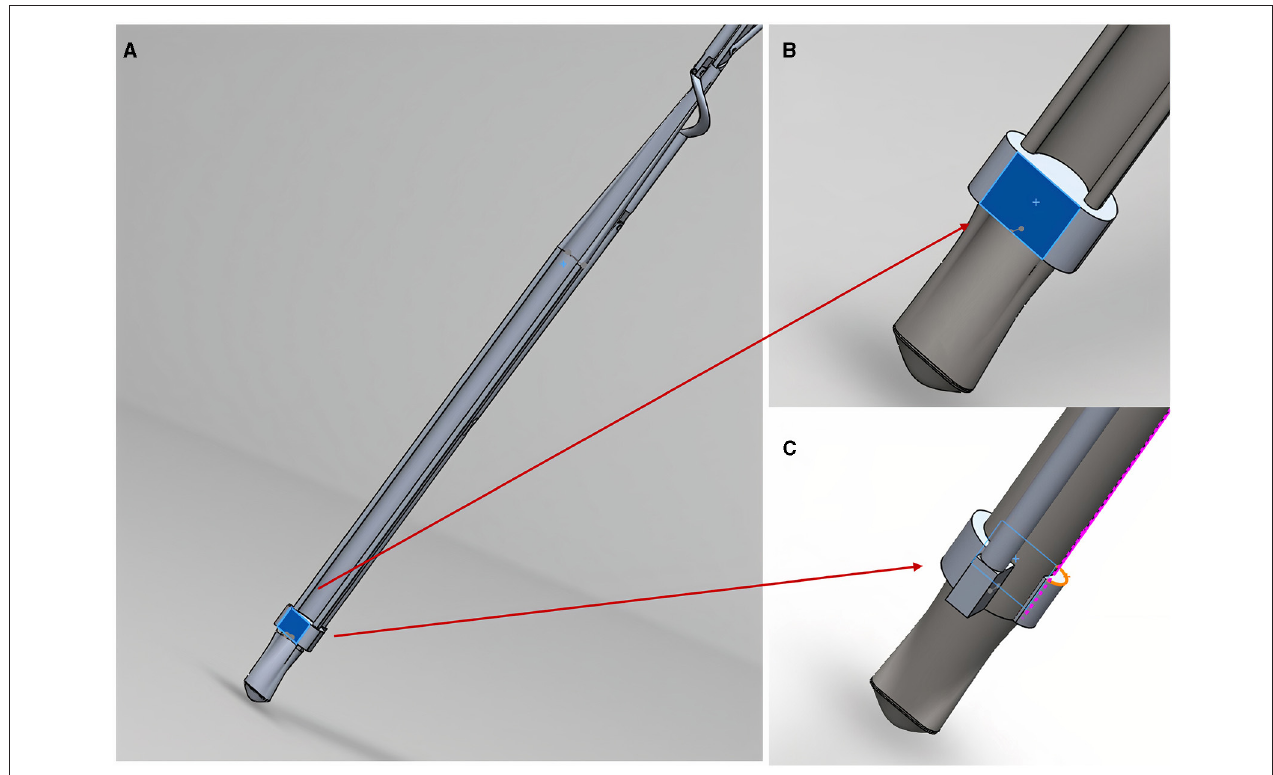
FIGURE 3 | The patch releasing mechanism in close-up. (A) Shows an arm patch attachment point/platform (highlighted in blue); (B) shows anterior view close-up of the platform where a hook/nodule (not shown) will attach patch corners; (C) shows a posterior view of the platform shown in (B)